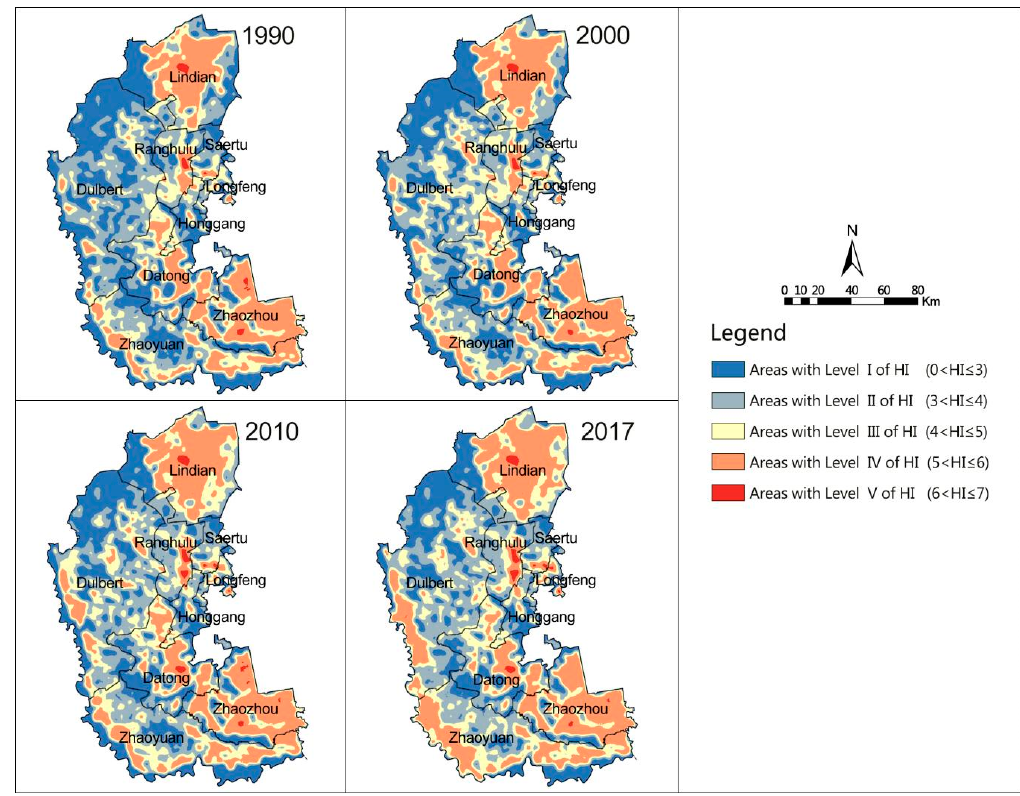
Figure 5. The changes of hemeroby index in the spatial dimension for four years.